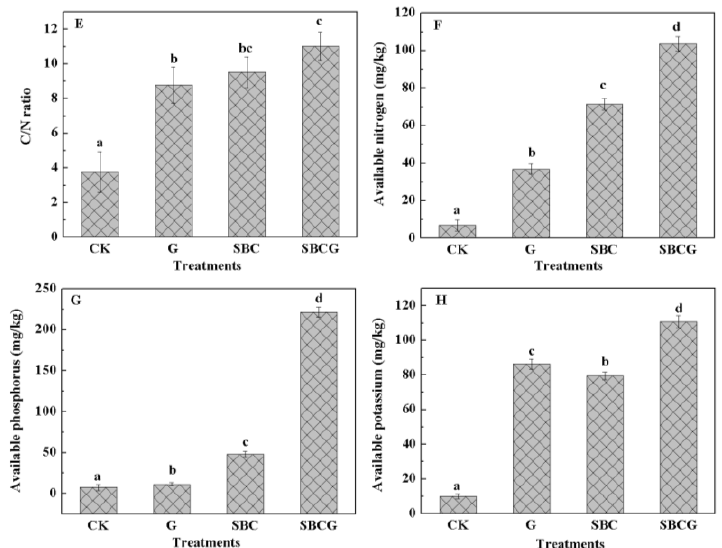
Figure 2. The chemical properties (( A – H ) stand for pH, electrical conductivity, organic matter, total nitrogen, C/N ratio, available nitrogen, available phosphorus, available potassium, respectively) of IAC mining wasteland soil in the un-amended control (CK), alfalfa revegetation (G), sludge biochar amendment (SBC), and combined amendment (SBCG) treatments. Different characters, a, b, c, and d were used to indicate significant differences at p < 0.05. Vertical bars indicate standard deviation.